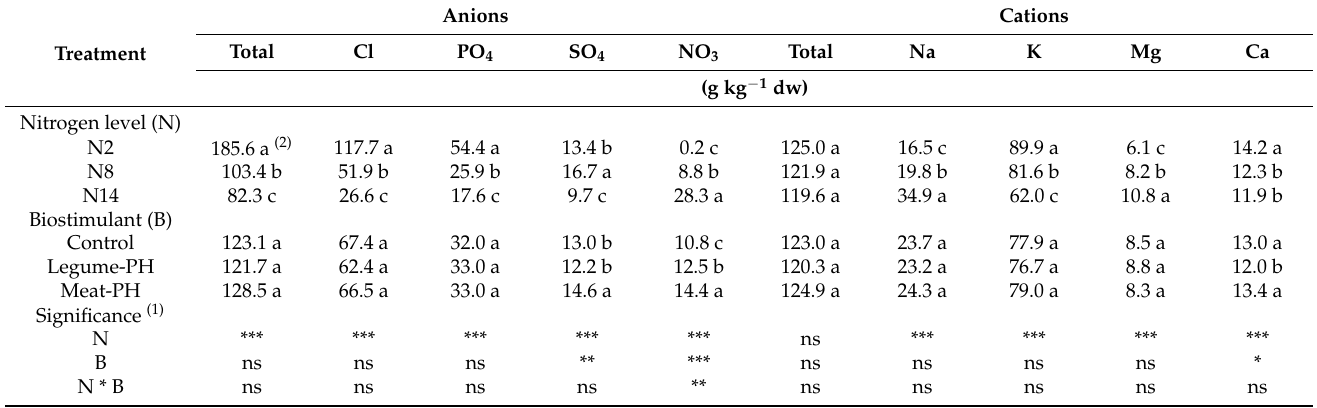
Table 5. Mineral status of spinach leaves as affected by nitrogen nutrition and by foliar application of